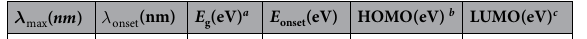
λ nm ( ) max λ onset (nm) E g (eV) a E onset (eV) HOMO(eV) b LUMO(eV) c 337.5 Table 1. Optical and electrochemical properties of GO. a E g is estimated from the UV-vis absorption edge wavelength (ledge) using the Planck equation: band gap = from the C - V onset ionization potential ( E onset ) using ferrocene as the external reference (4.8 eV below the vacuum level): E HOMO = − [ E onset - E ferrocene + 4.8)] (eV). E ferrocene is determined to be 0.38 V vs . Ag/AgCl. c E LOMO is determined from the equation: E LOMO = E HOMO + E g57